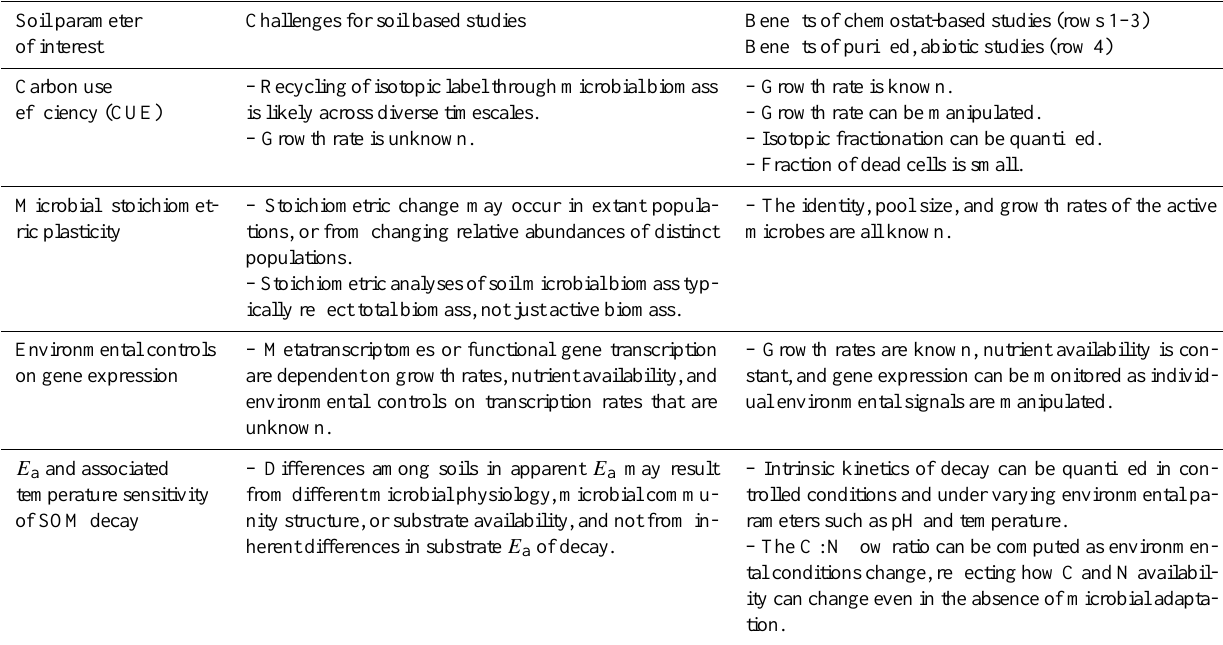
Table 1. Parameters frequently of interest for empirical and theoretical investigations of SOM transformations (left column), typical chal- lenges encountered when interpreting data derived from soil studies (middle column), and the benefits of employing chemostats (rows 1 through 3, last column) and purified substrate–enzyme reactions (row 4, last column). Controlled environments where microbial populations and environmental conditions can be strictly monitored provide unique insights that can be used to develop hypotheses for soil-based studies or parameterize models of SOM transformations. See Sects. 2 and 3 for detailed explanation of all table